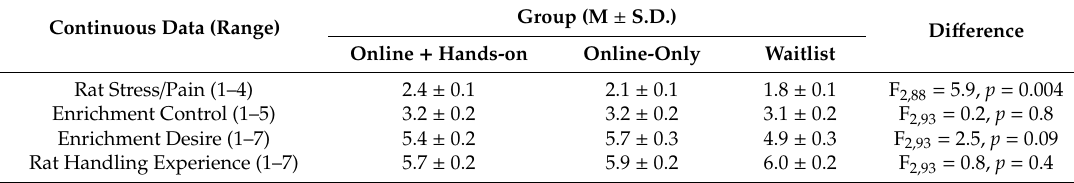
Table 1. Baseline characteristics of laboratory animal personnel across treatment groups ( n =